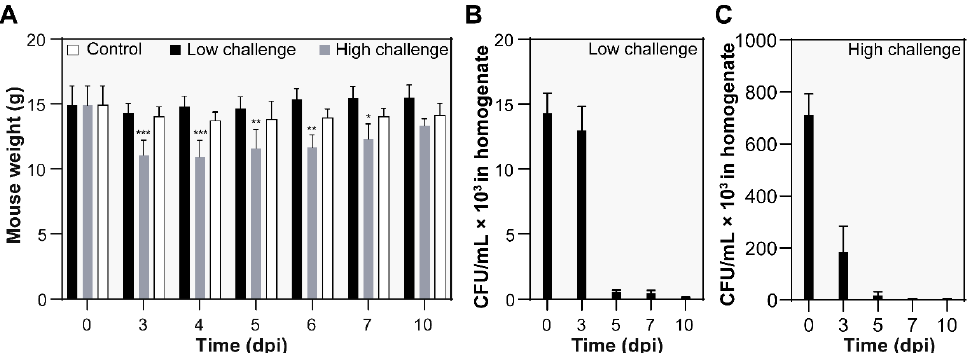
Figure 1. General appearance and clinical signs of intranasally A/JOlaHsd mice inoculated with the L. pneumophila isolate. ( A ) Body weight course during the infection. Statistical significance was evaluated compared to the control group by ANOVA. ( B , C ) L. pneumophila Sg 1, ST 62, Mab Knoxville burden in lungs. At specific time points of both the low ( B ) and high dose ( C ) challenge, the animals were sacrificed, and the CFU value was estimated in lung tissue homogenates. The results indicate mean values ± SD. Asterisks indicate statistical significance compared with the noninfected control (* p ≤ 0.05, ** p ≤ 0.01, and *** p ≤ 0.001).